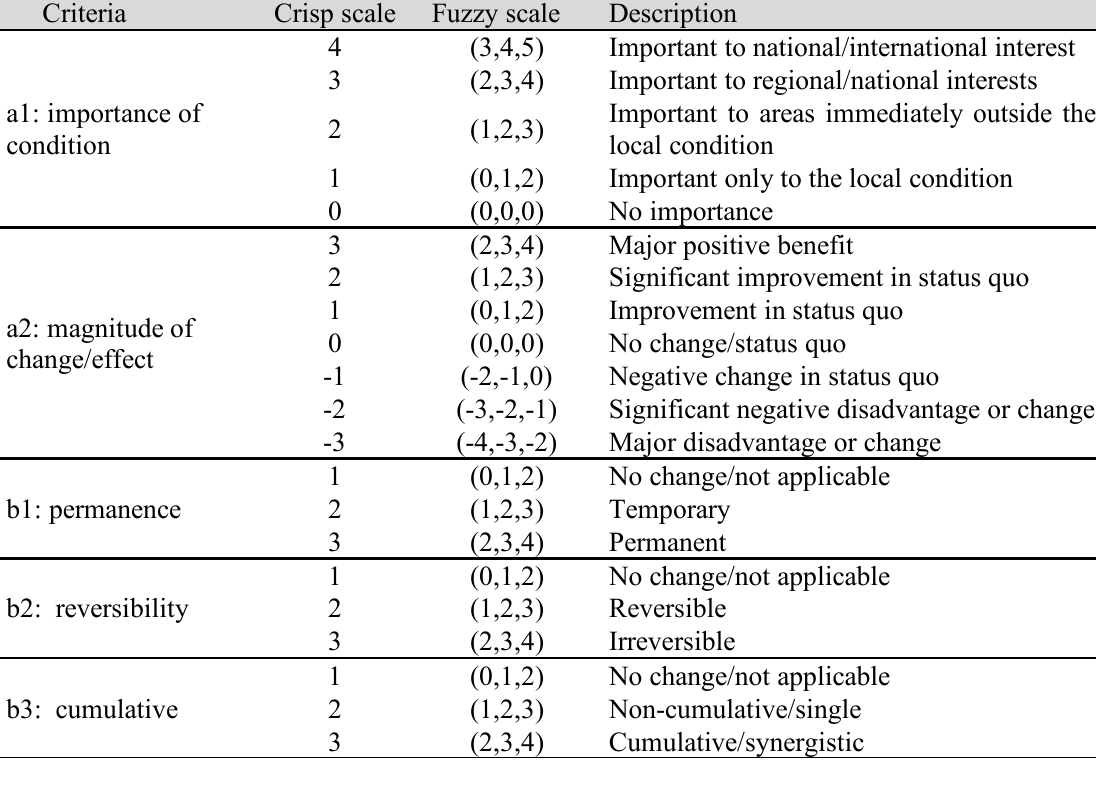
Table 1. RIAM method Assessment criteria Criteria